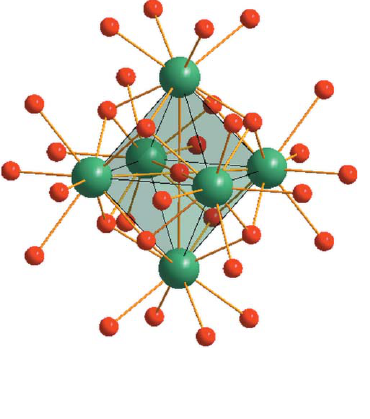
Figure 1 The asymmetric unit of the title complex. Displacement ellipsoids are drawn at the 50% probability